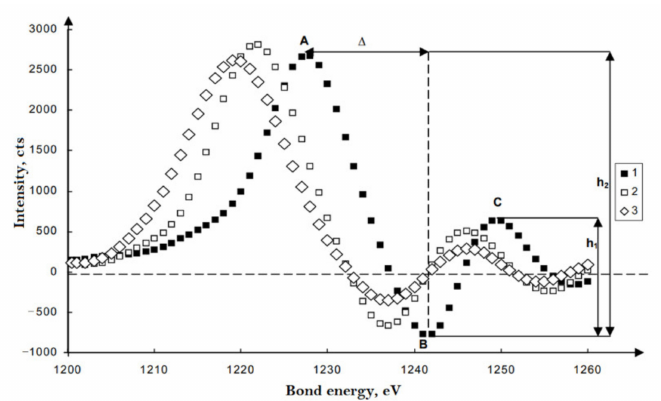
Figure 13. Derivatives of the Auger spectra of PVDF and its radiation carbonization products: h1 and h2 are, respectively, the intensities of singularities C and A with respect to the minimum of B; ( ∆ ) is the Galuska criterion (the difference between the energy positions of the minimum B and maximum A) [109]. ( (cid:4) )—original PVDF; ( (cid:3) )—PVDF subjected to X-ray carbonization at maximum exposure; ( ¯ )—PVDF carbonized with ions at the maximum